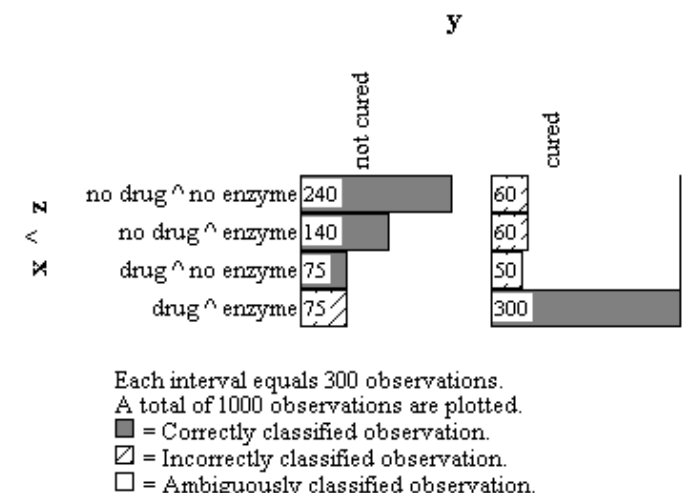
Figure 8. Multigram showing summary pattern for all observations on the three orderings: drug ingestion (X), enzyme secretion (Z), and disease state